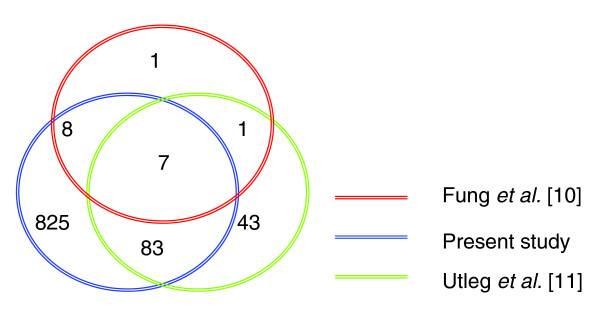
A comparison between proteins identified in the present study and two proteomics datasets published recently [10,11].